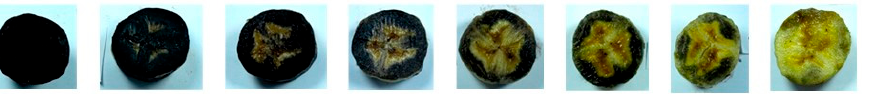
Figure 4. Colored images of the fruit ripening of the iodine-stained banana flesh during the 21-day storage period (i.e., days 2, 4, 7, 9, 11, 14, 17, 21). Table 1. Variations of the feature mean values of the intensities of all the grayscale image pixels of the iodine-stained banana flesh, on days 2, 4, 7, 9, 11, 14, 17, 21 of storage.